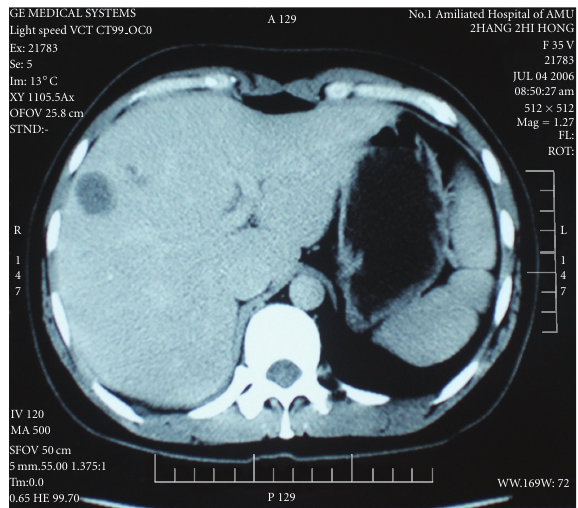
Figure 1: CT showed one low-density lesion under the right hepatic lobe capsule for case 1.